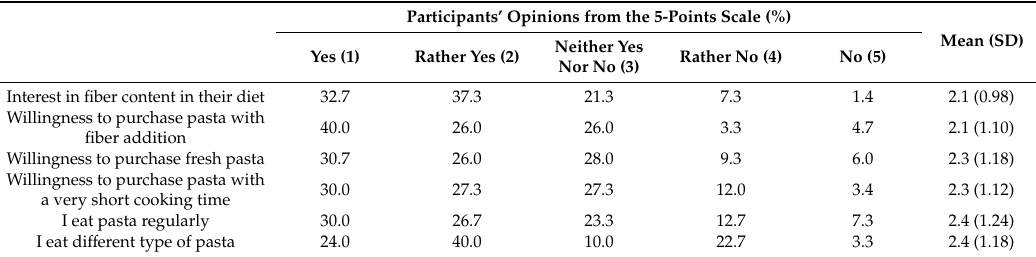
Table 2. Characteristics of the consumer group regarding frequency of eating and willingness to purchase pasta, and interest in fiber.